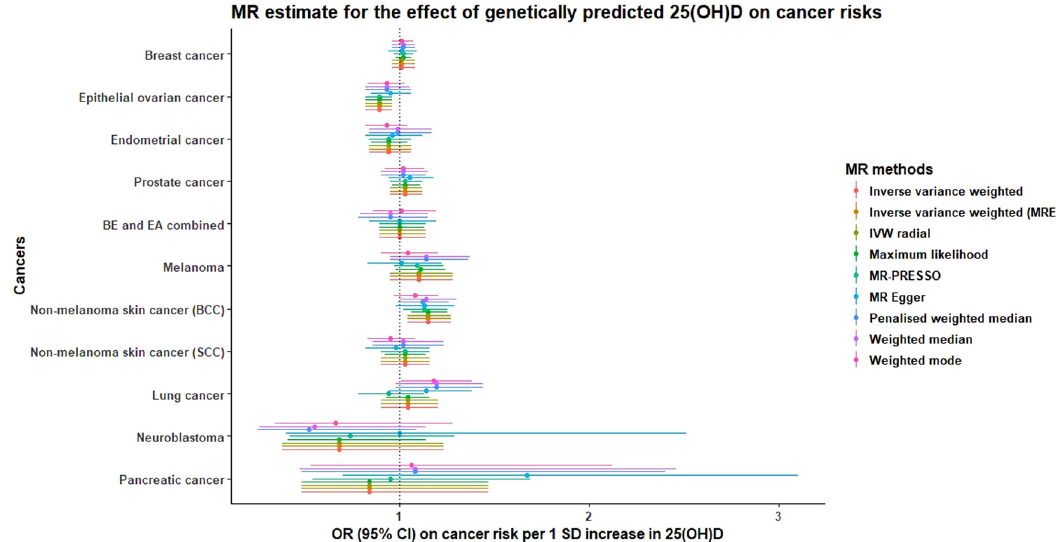
Fig. 1 MR association between 1SD increase in genetically predicted 25(OH)D concentration and risk of cancers estimated via multiple two-sample MR model. BE and EA combined refers to Barrett ’ s oesophagus and oesophageal cancer combined. The y -axis represents the estimated OR (and the corresponding 95% CI) on individual cancers per 1 SD change in genetically predicted 25(OH)D.